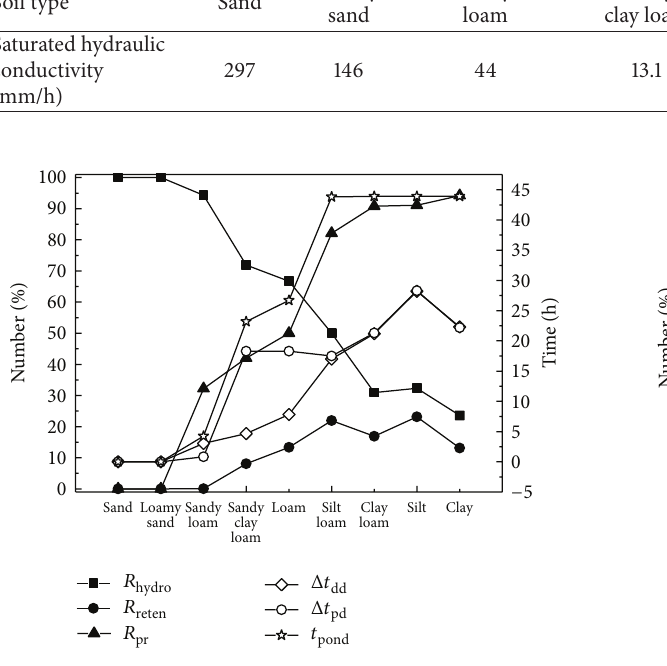
Figure 7: Hydrologic performance of bioretention measures under different filter soils.